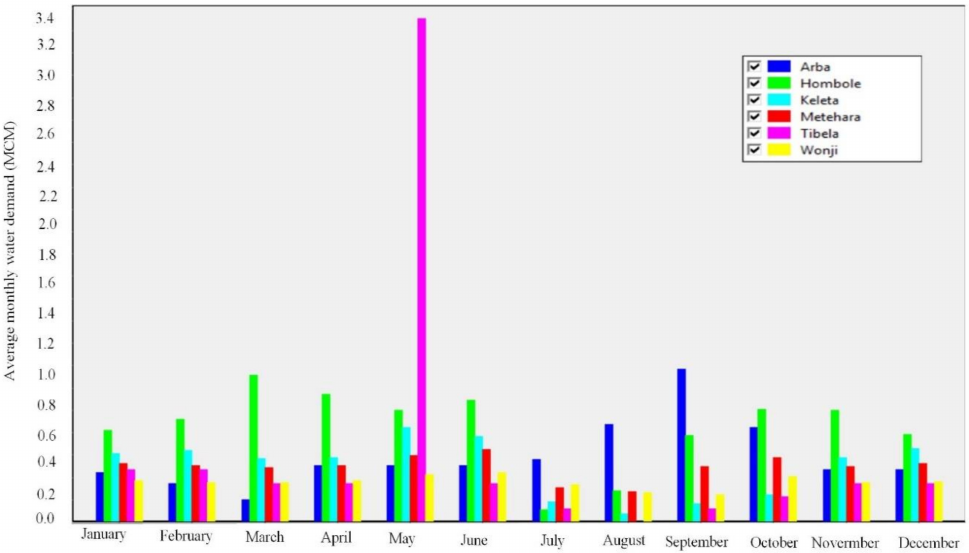
Figure 5. Mean monthly current demands without including losses.